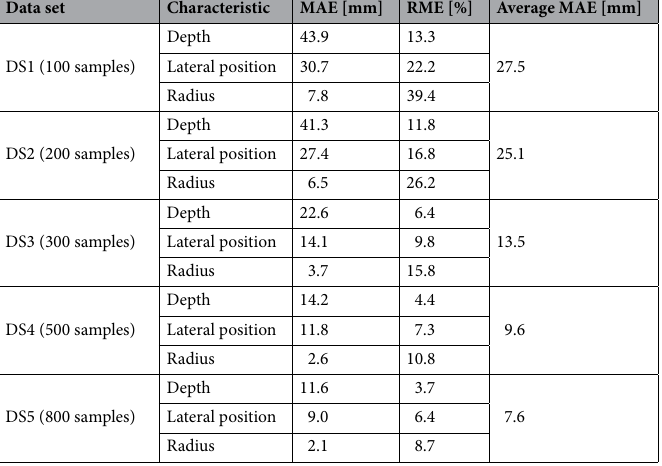
Table 2. Prediction performance of considered characteristic parameters for the proposed M2LP framework.